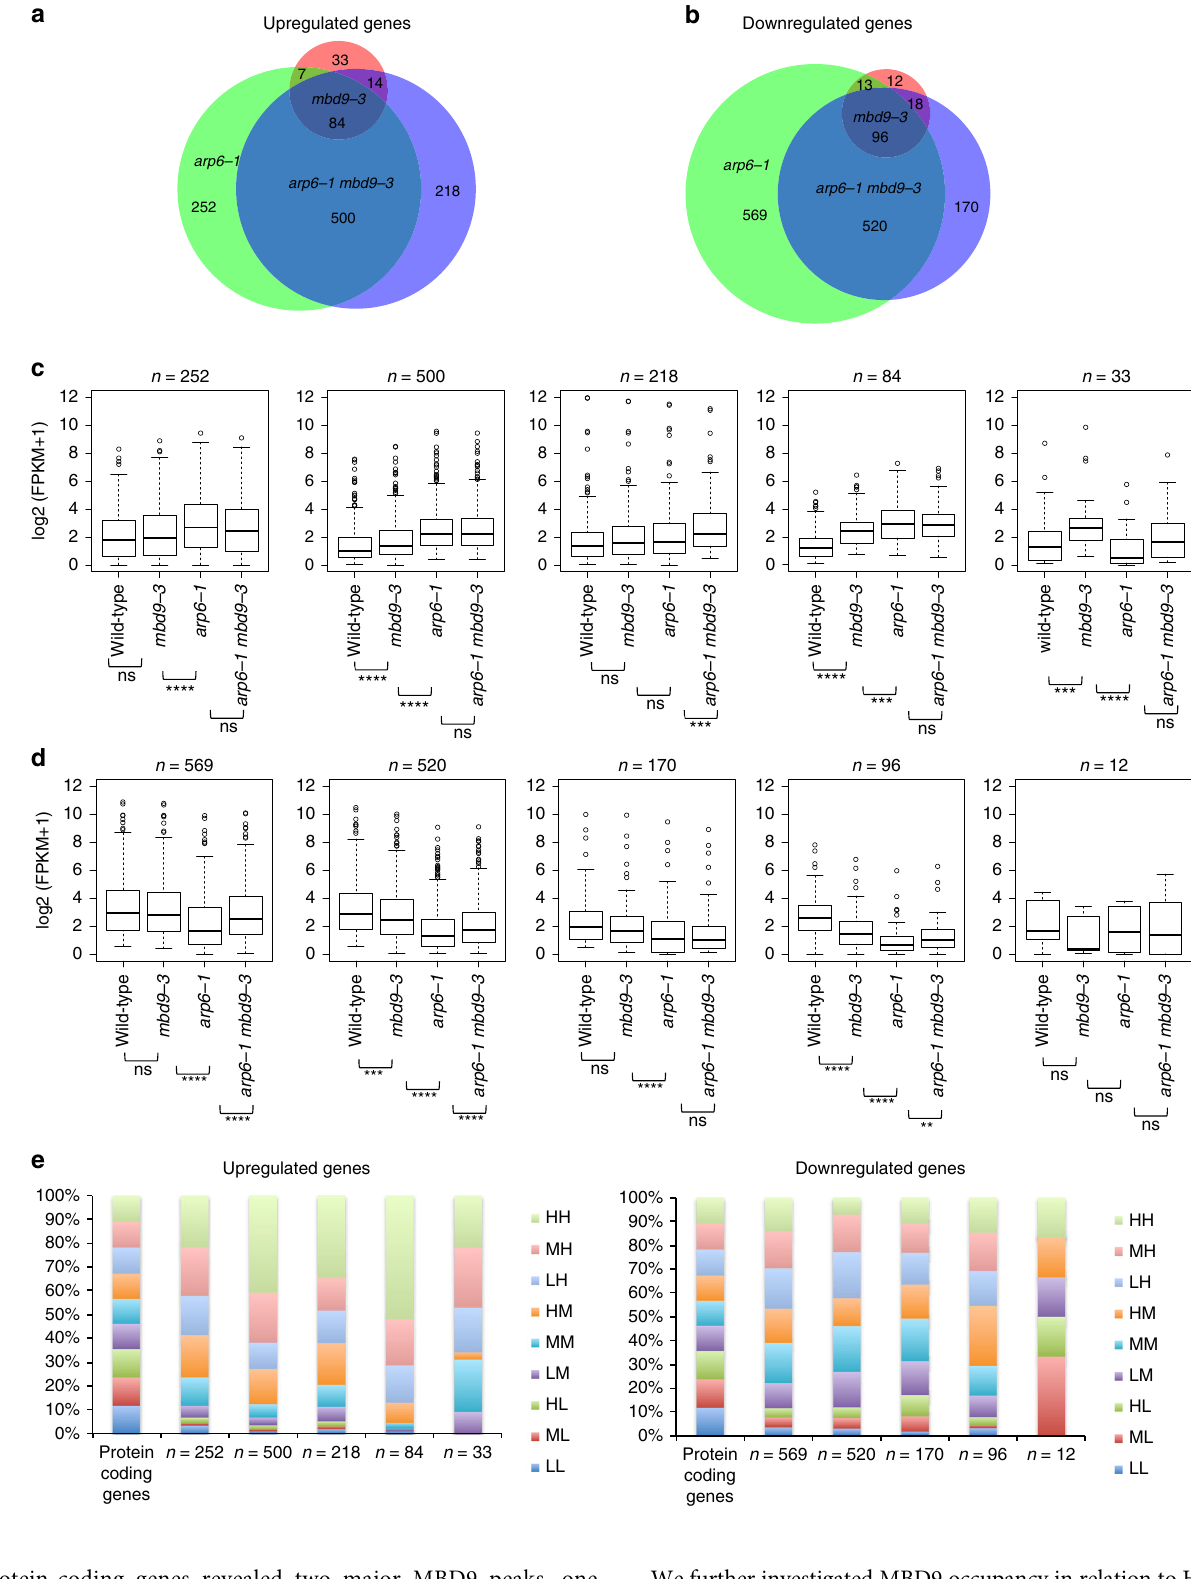
protein-coding genes revealed two major MBD9 peaks, one over nucleosome-depleted regions just upstream of the TSS and a smaller peak just 3 ′ of the transcription end site (TES) (Fig. 4d). At the 5 ′ end, the MBD9 peaks overlap with the ATAC-seq peaks and are just upstream of the H2A.Z peak (Fig. 4d, e).